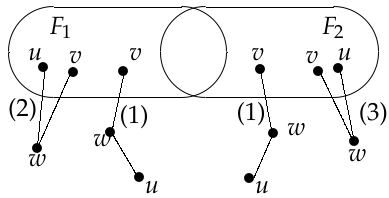
Figure 1. Illustration of a distinguishable pair ( F 1 , F 2 ) under the MM*